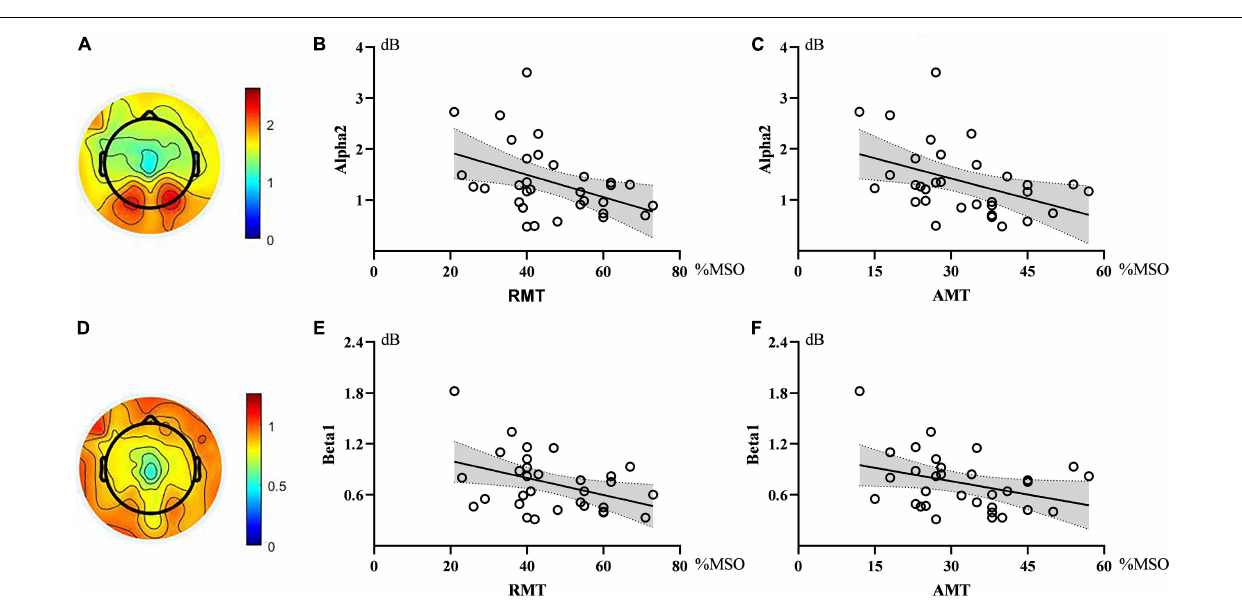
FIGURE 2 | Topographic maps and scatter diagrams. Topographic maps showed the power of alpha2 oscillations and beta1 oscillations. The color bar represents the value of power (A,D) . Scatter diagrams showed the correlation between electroencephalography (EEG) oscillations and motor threshold (B,C,E,F) . There were significant negative correlations between alpha2 and RMT as well as